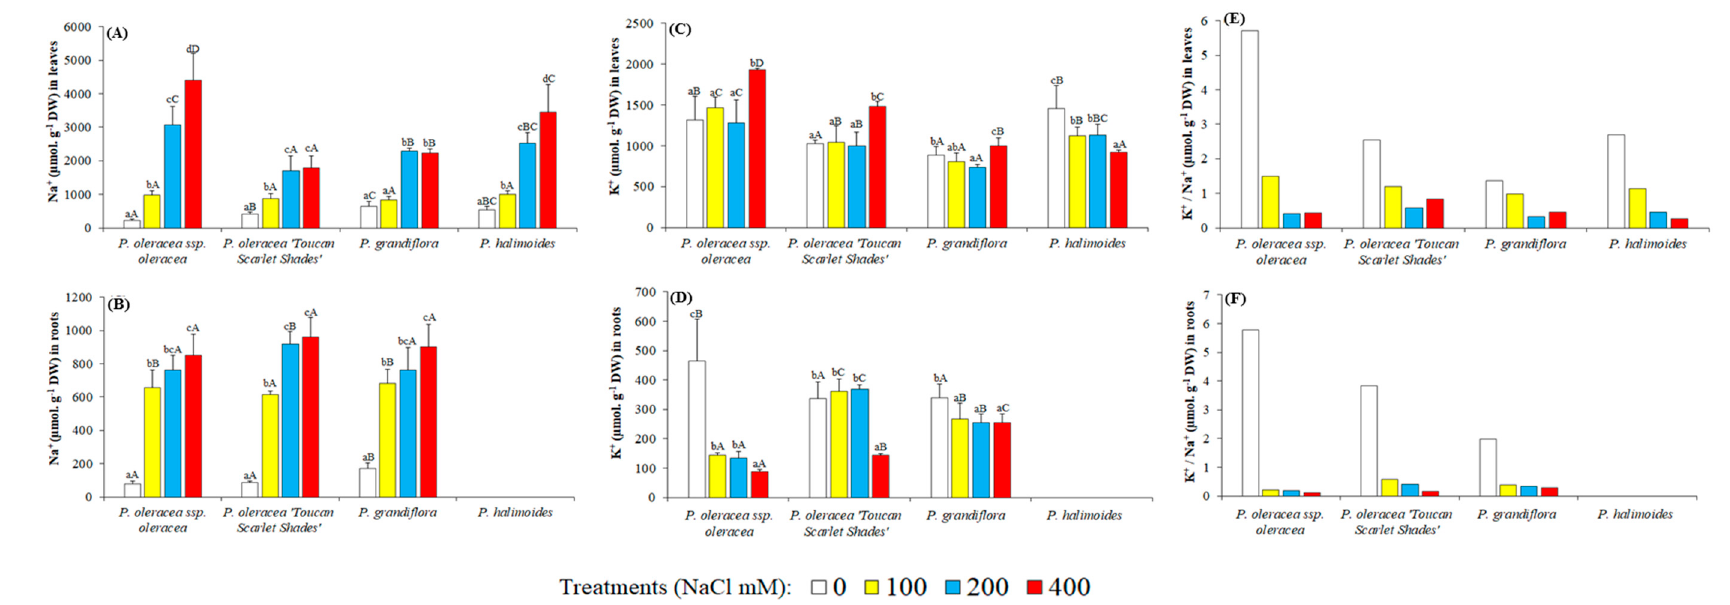
Figure 6. Ion content of leaves and roots of the 4 studied Portulaca genotypes undergoing 5 weeks of salt treatments (up to 400 mM NaCl). Sodium and potassium concentrations, as well as potassium over sodium ratios in leaves ( A , C , E , respectively) and roots ( B , D , F , respectively). The values shown are means ± SE (n = 5). Di ff erent lowercase letters above the bars indicate significant di ff erences between the control plants, and di ff erent capital letters indicate significant di ff erences between different genotypes.